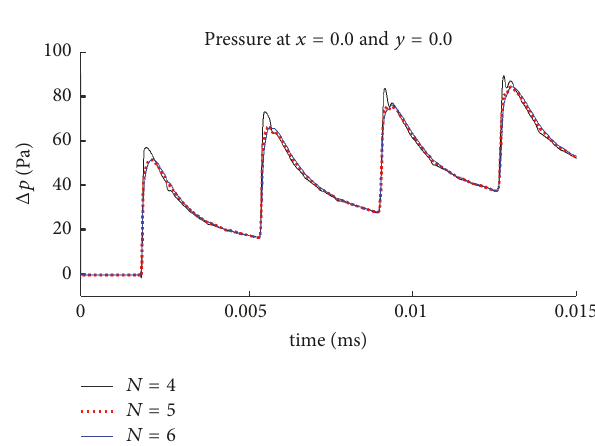
Figure 12: Pressure history at the center of the domain for 𝑁 values from 4 to 6.